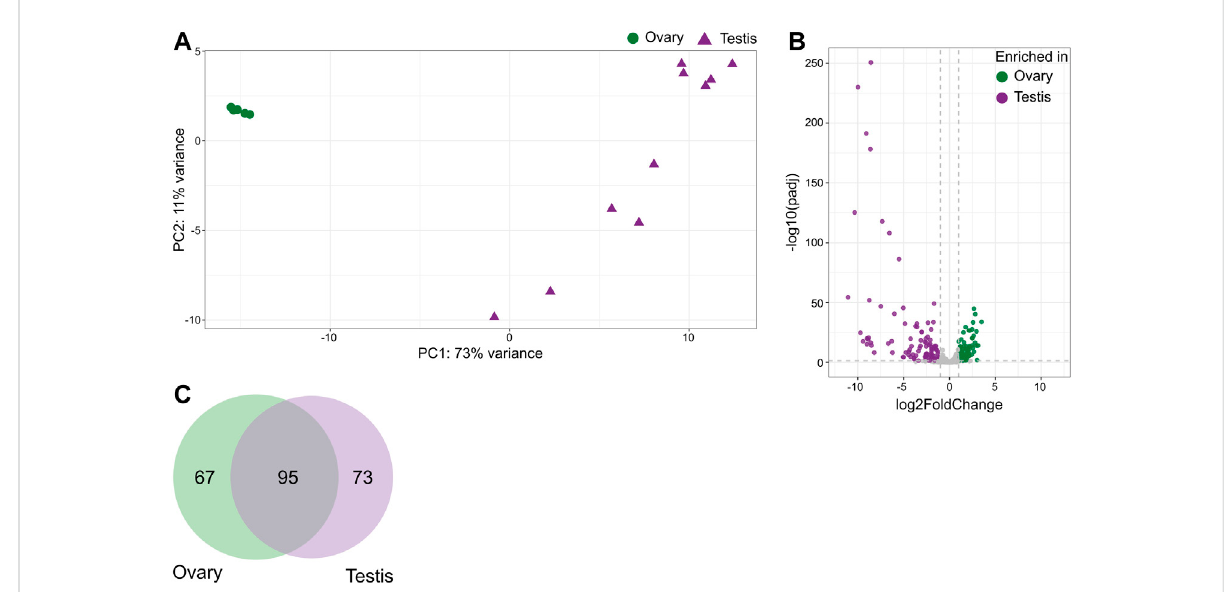
FIGURE 2 Distribution of miRNAs across gonadal tissues in the domestic cat. (A) Principal component analysis plot representing variations of mature miRNAs in ovarian and testicular samples. (B) Volcano plot showing differentially expressed mature miRNAs in ovary vs. testis tissues (Wald test, adjusted p -value < 0.05, absolute fold change ≥ 2). (C) Venn diagram of miRNAs precursors enriched in either ovary or